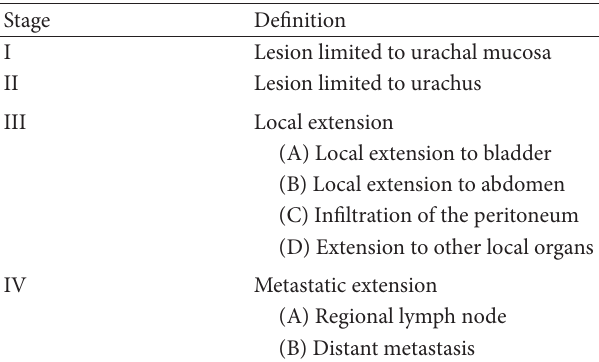
Table 1: Clinical staging in urachal